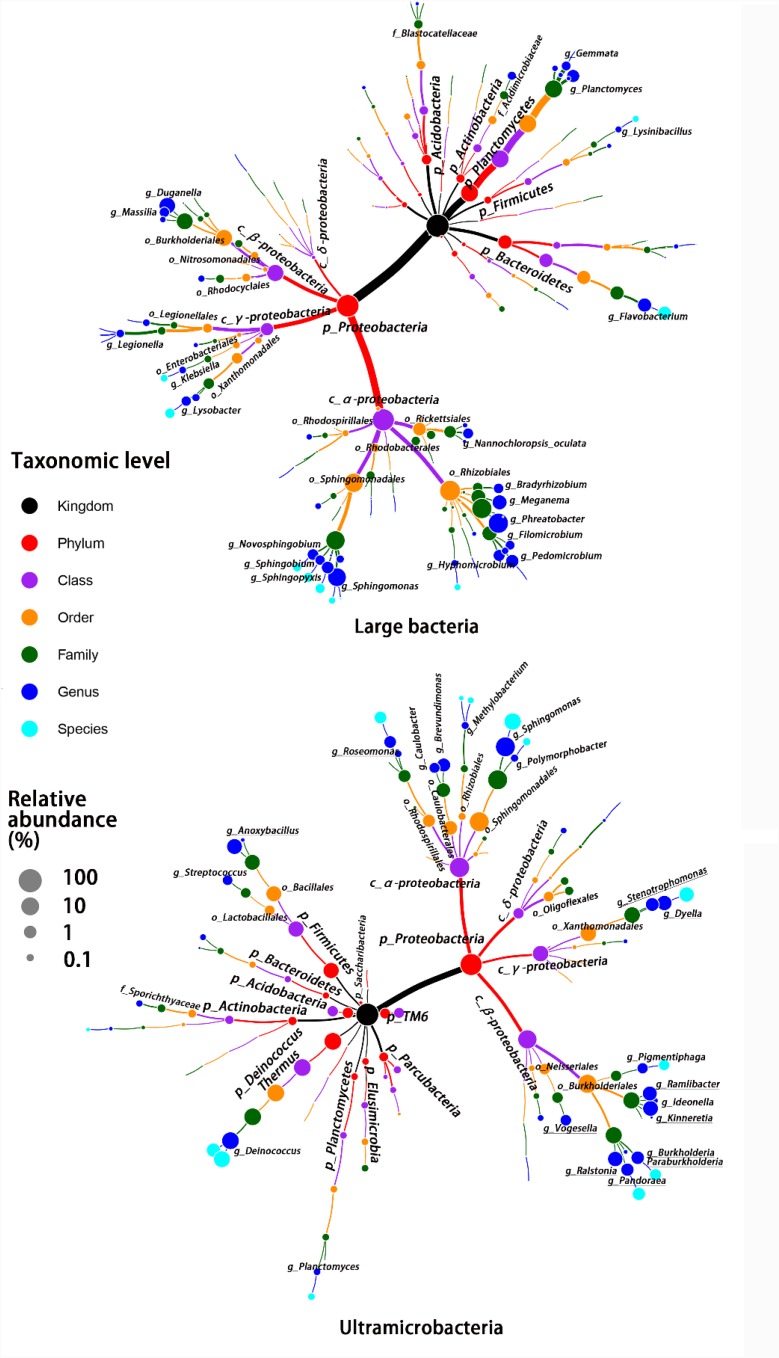
Taxonomic tree for LB and UMB indicator taxa composition at different taxon levels. Color and size of circles, respectively, represent the taxon level and average relative abundance of indicator taxa.